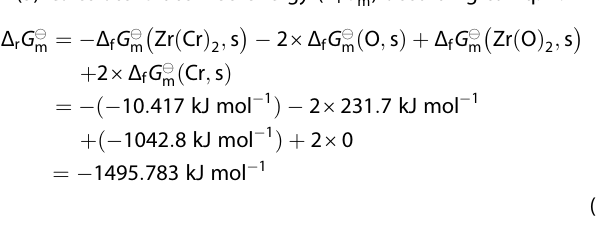
The Gibbs free energy of Reaction 4 is a negative number, which indicates the feasibility of this reaction. As talked above, for the Cr coating oxidized at 1200 o C for 4 h, the layers from outer to inner are Cr 2 O 3 , Cr(outer), ZrO 2 (outer), ZrCrFeO, Zr(Cr, Fe) 2 , Cr(inner), ZrO 2 (inner) and Zr in turn. In